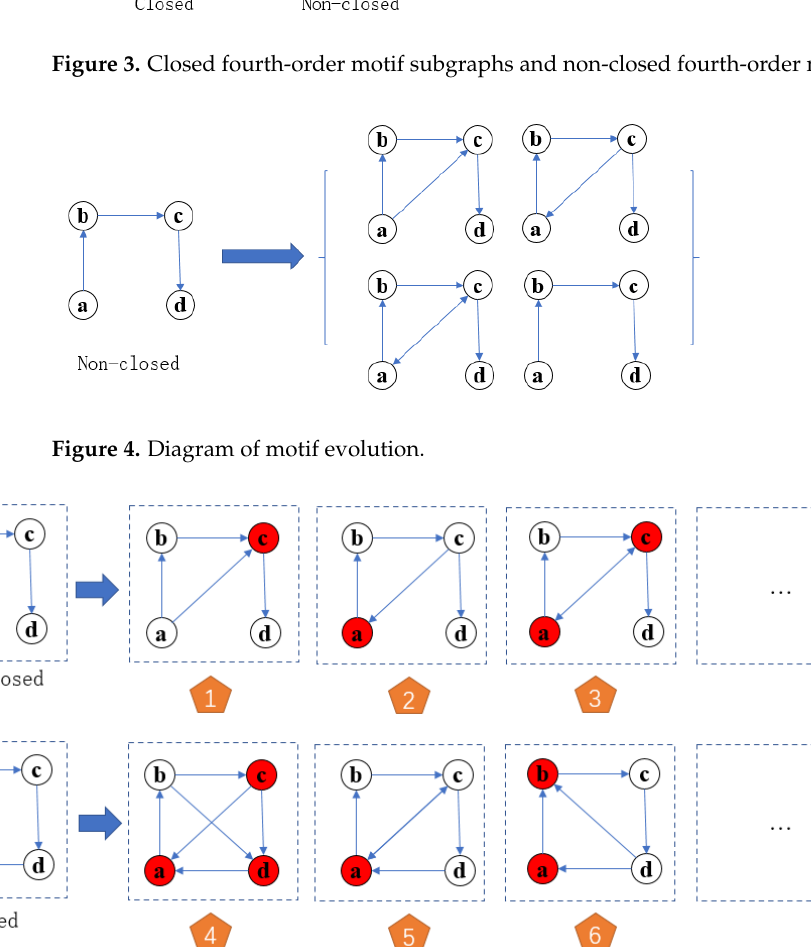
Figure 5. The motif evolution